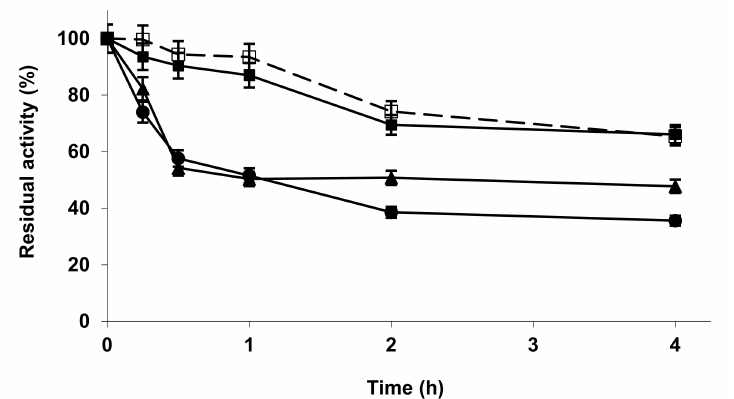
Figure 4. Inactivation courses of LS-IM unmodified and modified with metallic salt/sodium phos- phate. The inactivation was performed with 10 mM Tris buffer at pH 7.0 and 60 ◦ C. Other specifica- tions are described in the Methods section. Unmodified LS-IM (open squares and dotted line); LS-IM modified with ZnCl 2 /sodium phosphate (solid squares); CuCl 2 /sodium phosphate (solid circles); CoCl 2 /sodium phosphate (solid